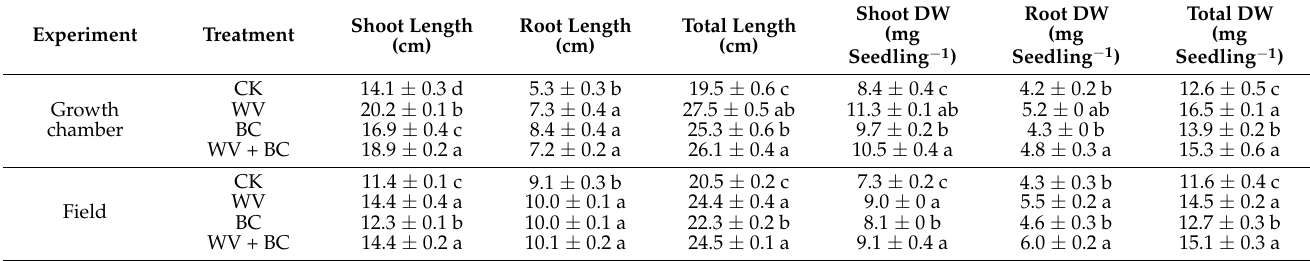
Table 4. Seedling growth attributes of different seed treatments of WDR under dry direct-seeded system.